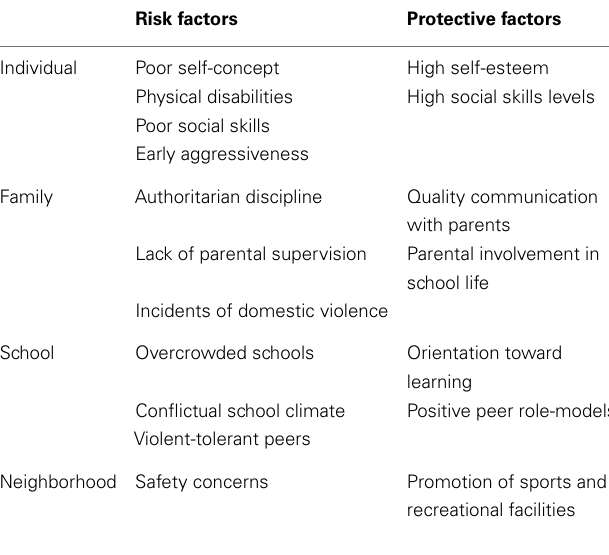
Table 1 | Risk and protective factors for bullying in multiple